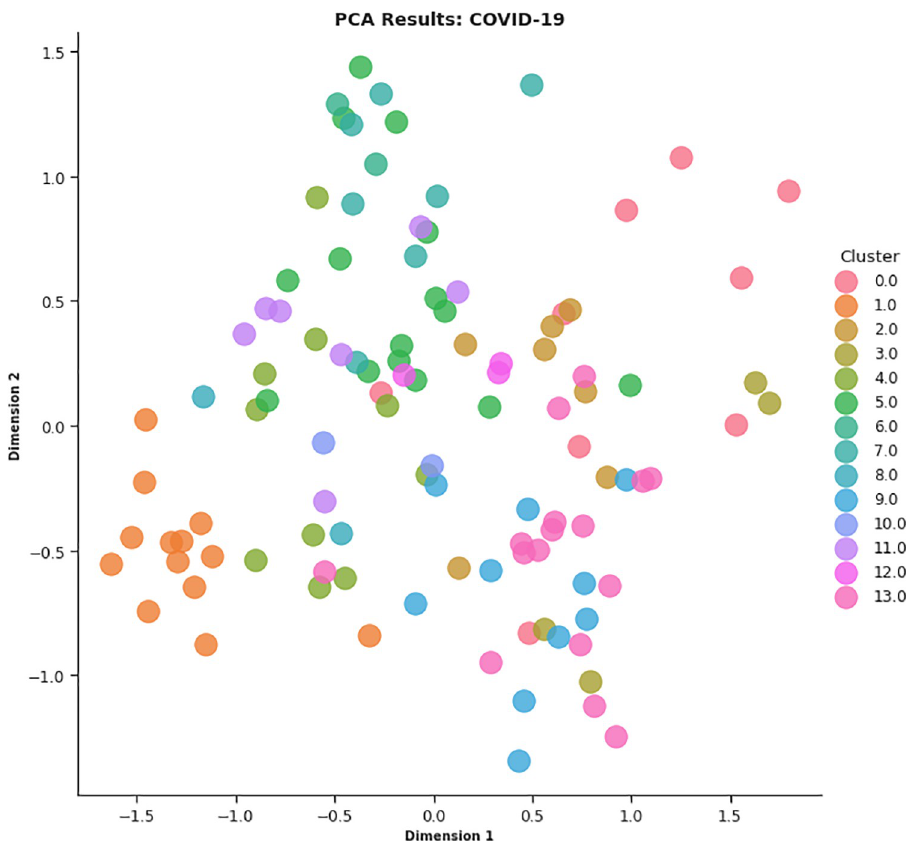
Fig 27. PCA visualization of clusters for